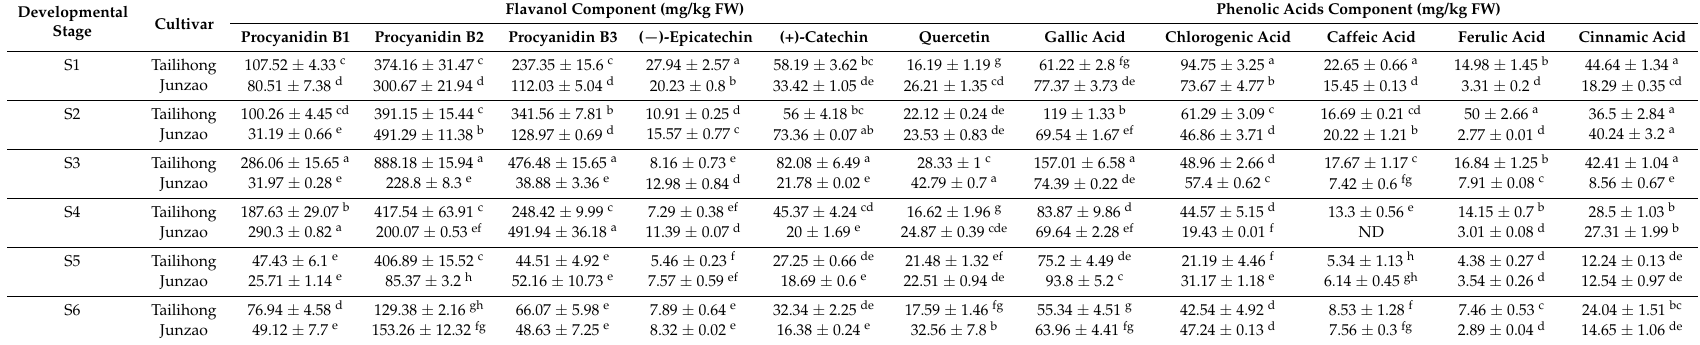
Table 1. Contents of individual phenolics in the skins of ‘Tailihong’ and ‘Junzao’ jujube fruit at different development stages.